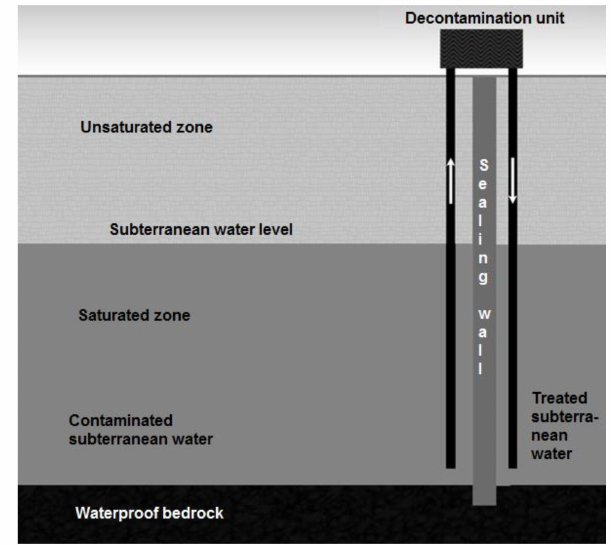
Figure 6. Proposed way of the presented Natura 2000 site